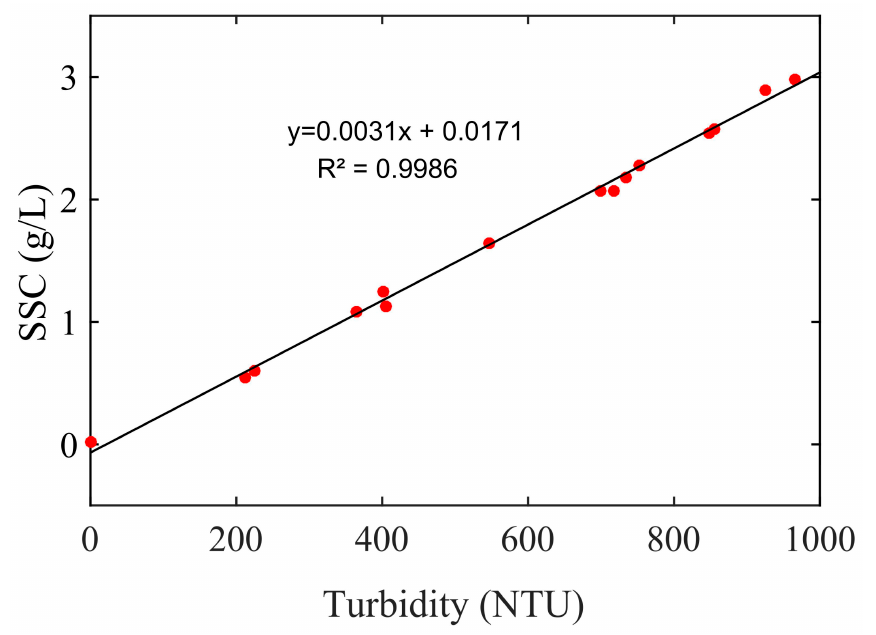
Figure 2. Correlation relationship between turbidity and SSC derived from calibration experiments.